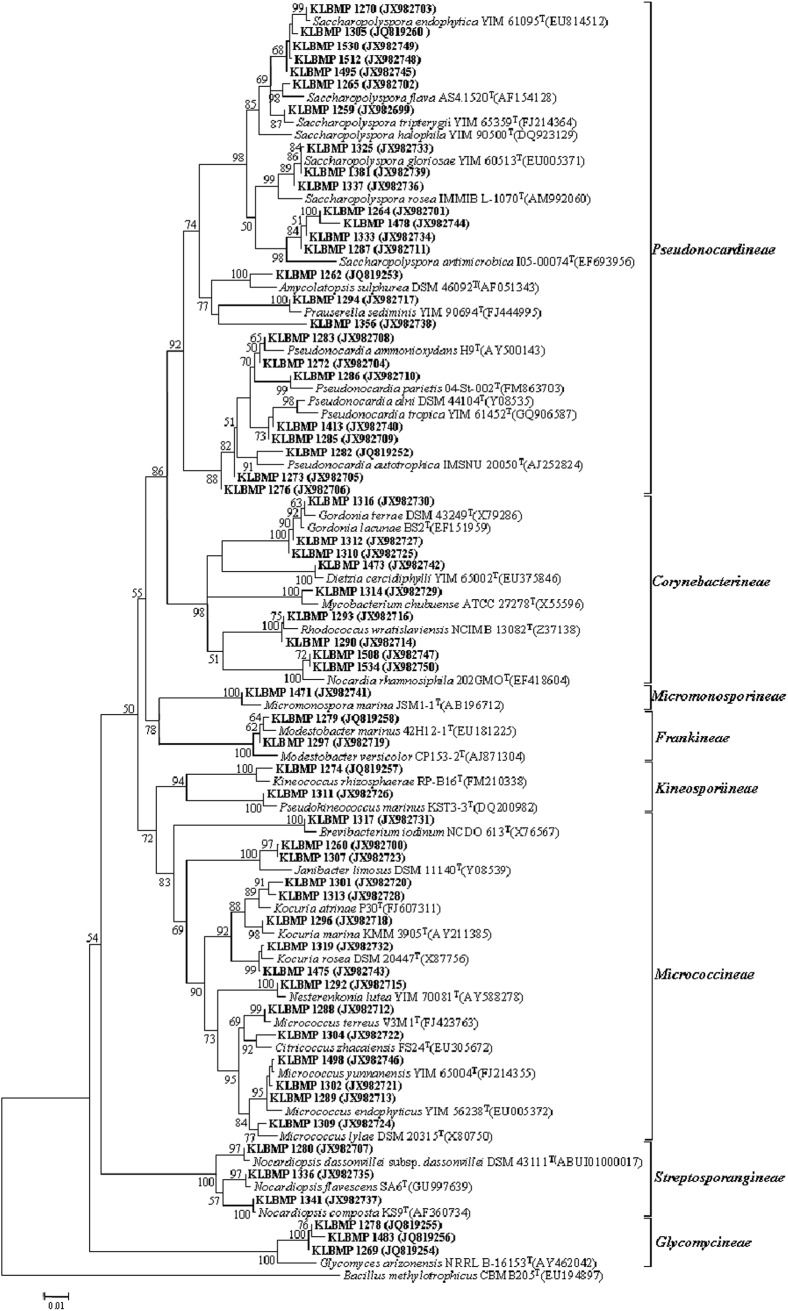
Neighbor-joining phylogenetic tree of 16S rRNA gene sequences obtained from non-Streptomyces isolates in this study and their phylogenetic neighbors. Only bootstrap values above 50% are shown at nodes and are expressed as percentages of 1,000 replicates. Bar represents 0.01 substitutions per nucleotide position. GenBank accession numbers of reference 16S rRNA gene sequences are shown next to isolate names. Bacillus methylotrophicus CBMB205T (EU194897) was used as the outgroup.